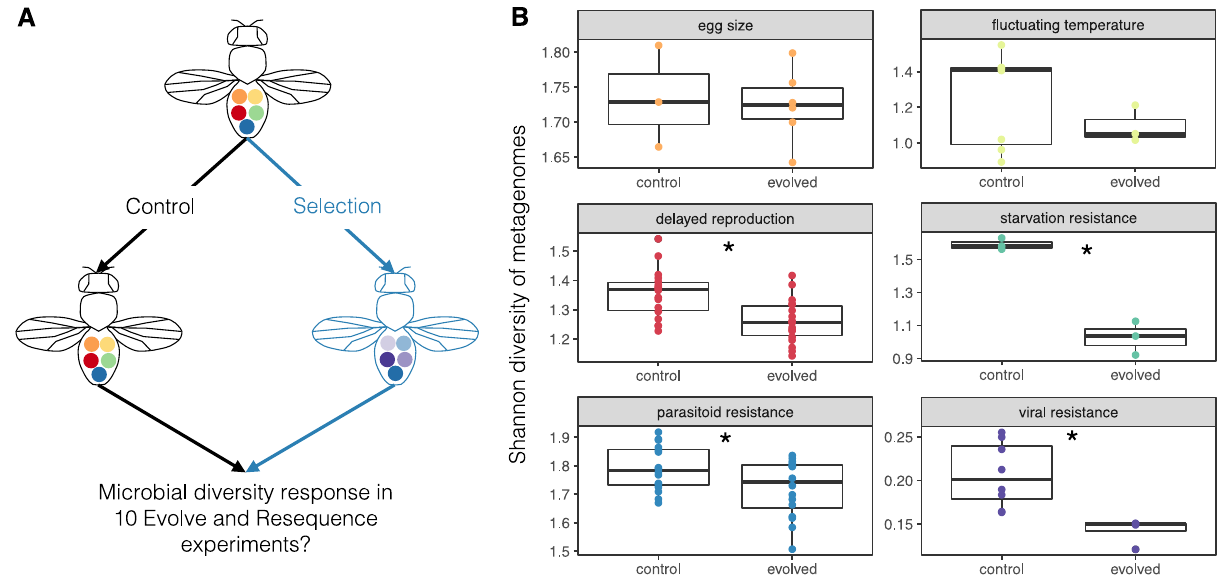
Fig. 2 Microbiome responds to host experimental evolution. Experimental evolution is a powerful tool to understand the genetic basis of adaptation. A Hypothesized schematic of the microbial response during adaptation in fl ies. B Microbial diversity is frequently reduced in evolved populations during experimental evolution in fl ies. Data is reproduced from Henry & Ayroles 123 . Here, each point represents Shannon diversity of metagenomes from a pool of sequenced fl ies. Asterisks denote the experiments where microbial diversity is signi fi cantly different between control and evolved